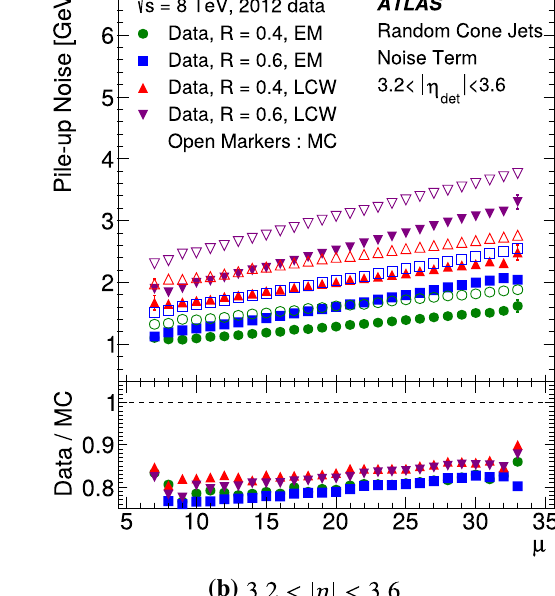
Fig. 51 The magnitude of the expected fluctuations in different jet radii at the constituent scale derived using the random cone procedure as a function of μ , for data (filled markers) and MC simulations (open markers). The results are shown for R = 0 . 4 and R = 0 . 6 cones and at